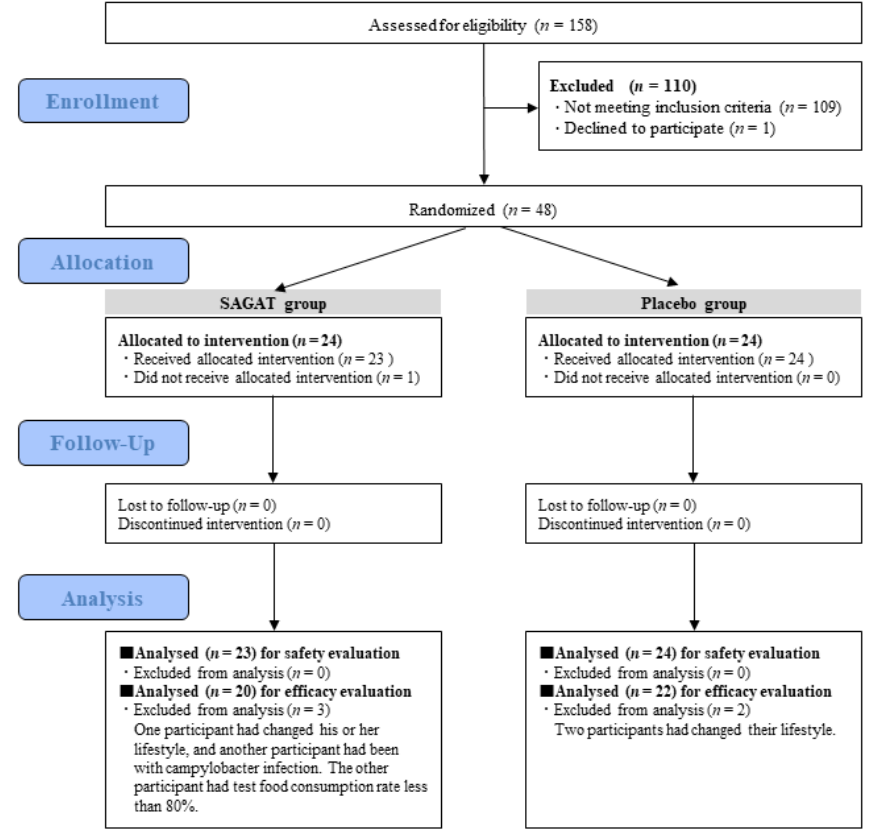
Figure 2. The study flow diagram.